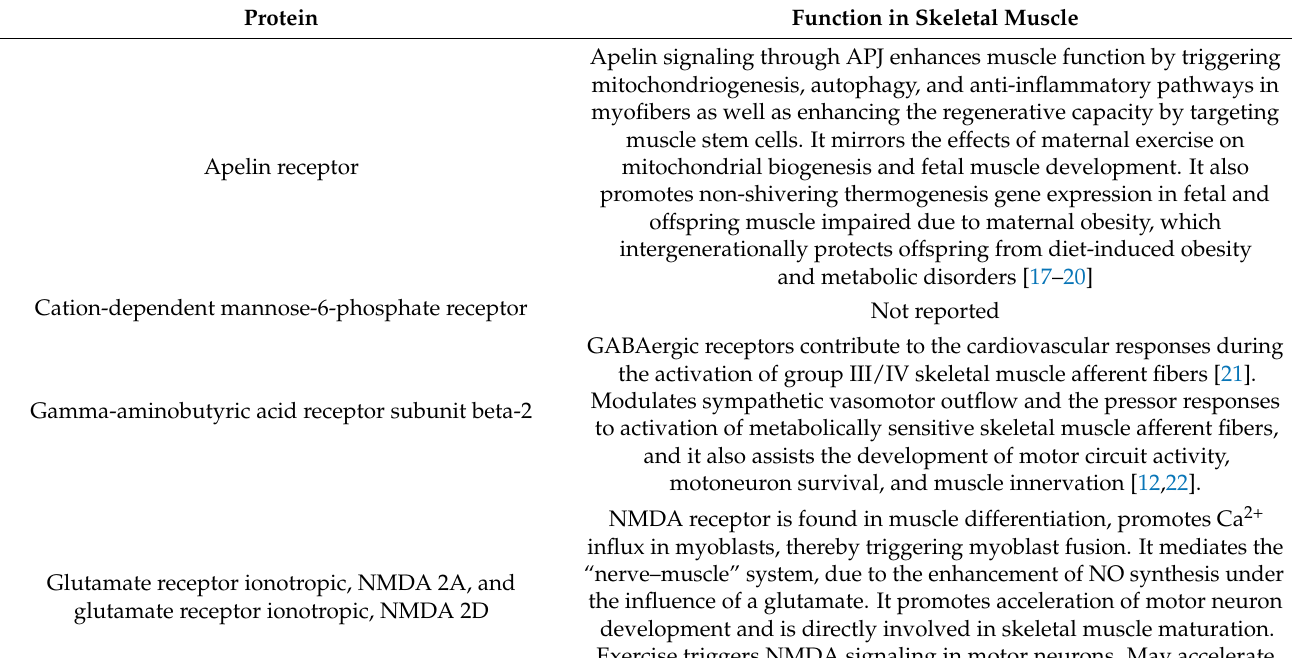
Table 1. Reported effects of EC-interacting isolated receptors on skeletal muscle.